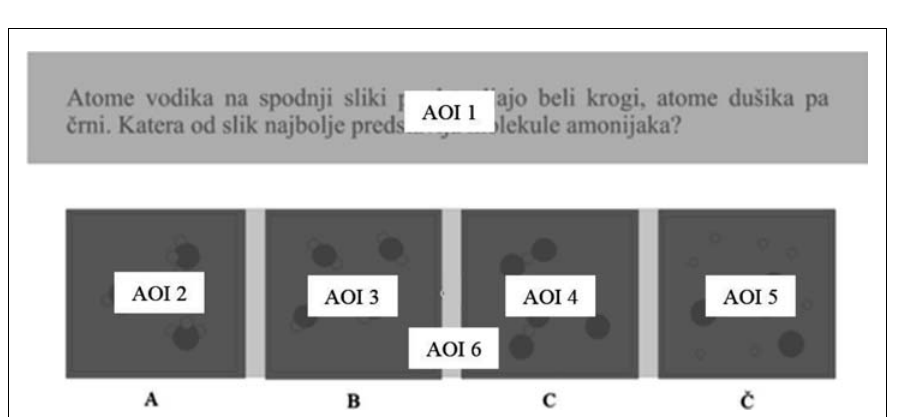
Figure 1. Example of a task divided into AOIs (AOI 1 = instructions including the textual explanatory key; AOI 3 to AOI 6 = particles investigated; AOI 2 = whole area of particles